Question: Sum up the contents of this chart in one sentence.
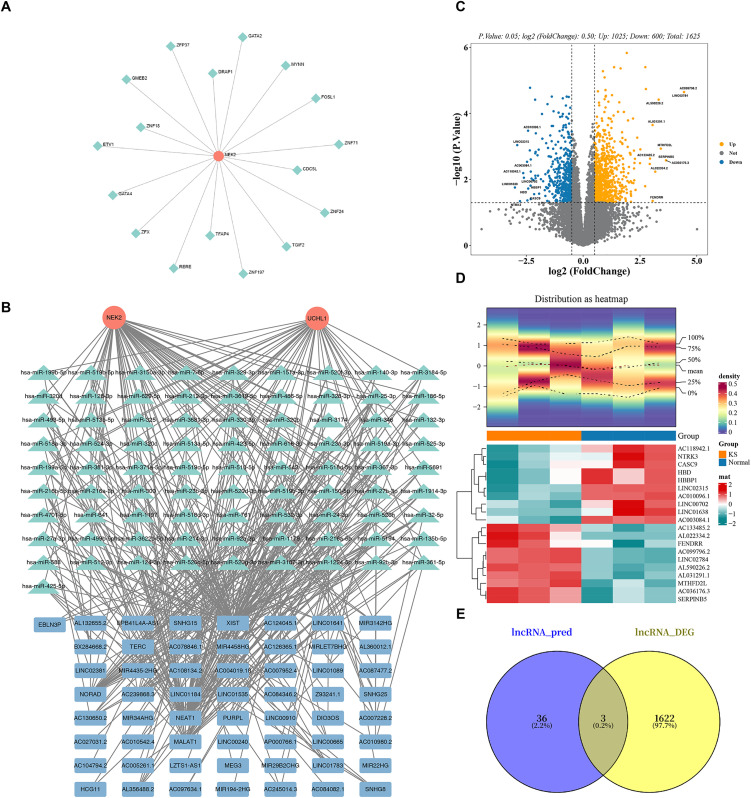
Answer: Molecular regulatory networks. (A) TF-biomarker network. (B) lncRNA-miRNA-biomarker network. (C) Volcano plot of differentially expressed lncRNAs between the KS and control groups. (D) Heatmap of differentially expressed lncRNAs between the KS and control groups. (E) Venn diagram of intersecting lncRNAs.